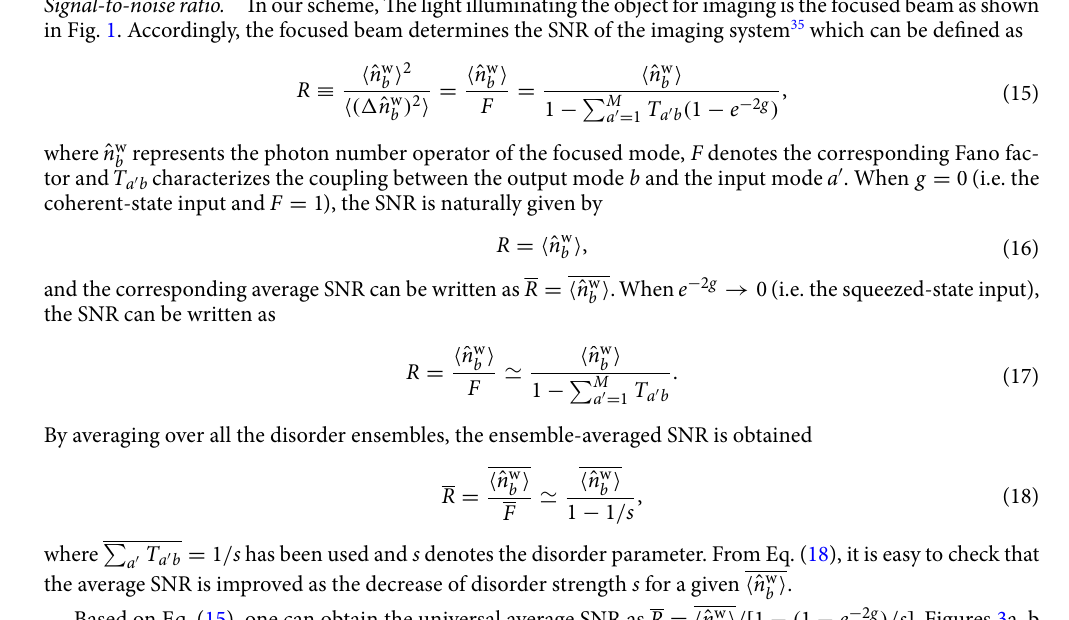
Figure 3. The ratio of the average SNR R to the mean photon number parameter g and ( b ) the disorder strength s of the scattering lens. The input is the product state of N squeezed 2 10000 α states. Parameters: | | =